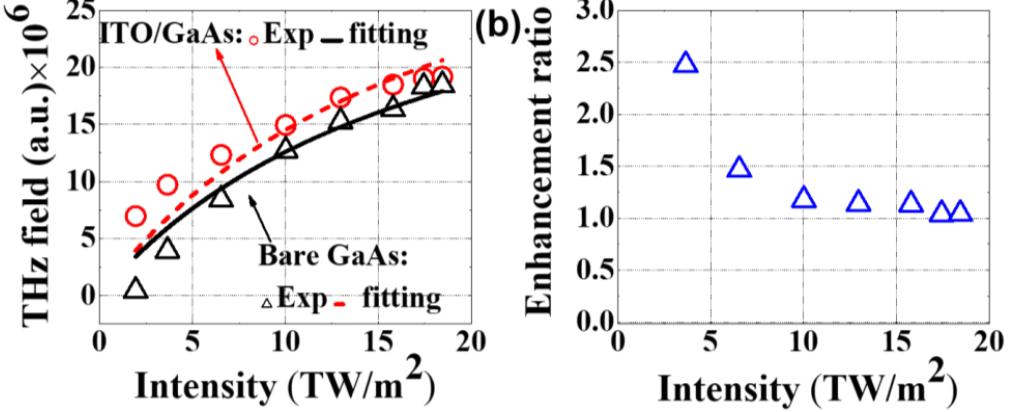
Figure 5. Optical pump intensity dependence. ( a ) THz emission from SI-GaAs and ITO/SI-GaAs and ( b ) emission enhancement ratio.